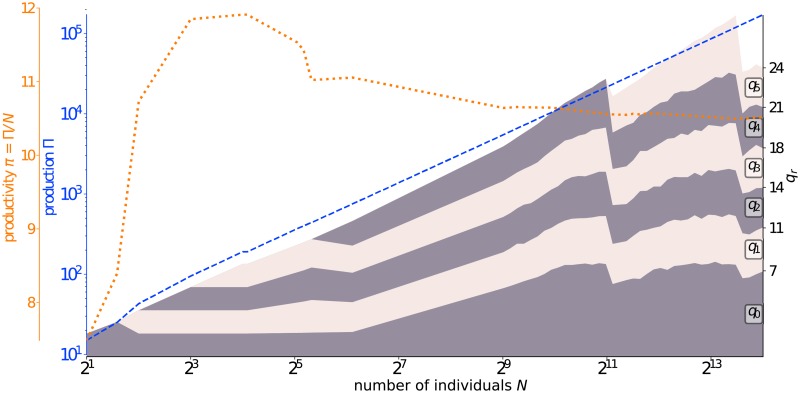
For β = 1.5, κ = 1, ω = 6 and η = 2, we show the dependence as a function of the total population number N (in logarithmic scale expressed in powers of 2) of three variables characterising the optimal hierarchical organisation determined and described in subsection 4.1: (i) total production Π (blue dashed line); (ii) productivity per individual, π ≡ Π/N (dotted orange line); (iii) optimal group ratios qr shown in stacked bands of alternating colours of dark grey and pink. The tick marks on the right y-axis show the sizes qr of the groups for N = 214, for which the optimal structure is given by p* = 4 with q0 ≈ 7, q1 ≈ 4, q2 ≈ 3, q3 ≈ 4, q4 ≈ 3 and q5 ≈ 3.